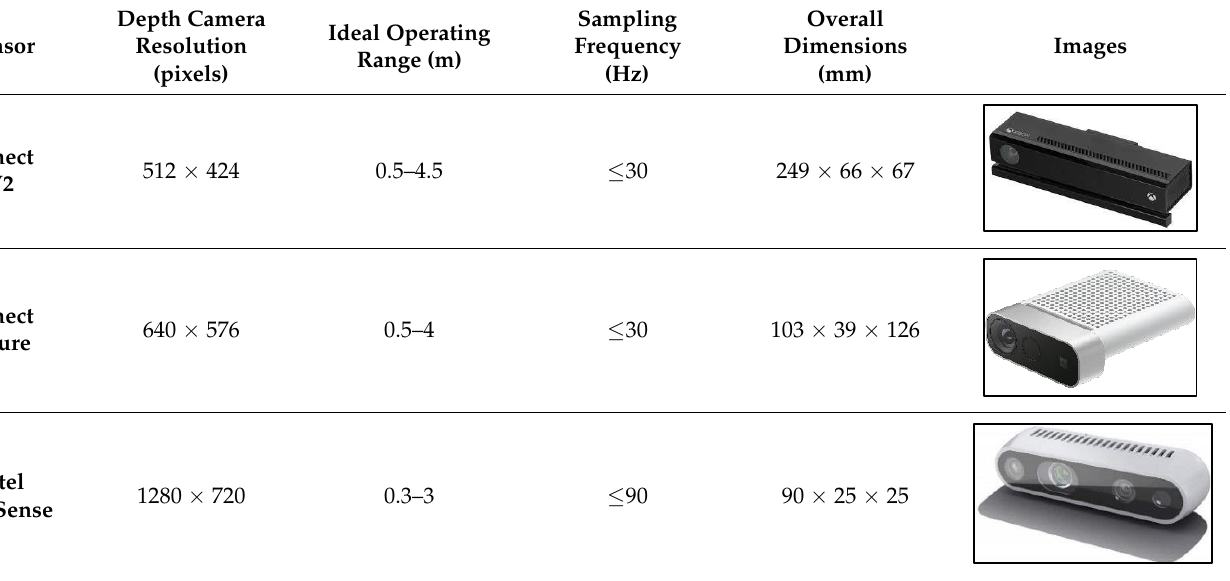
Table 1. Hardware specifications of depth sensors.